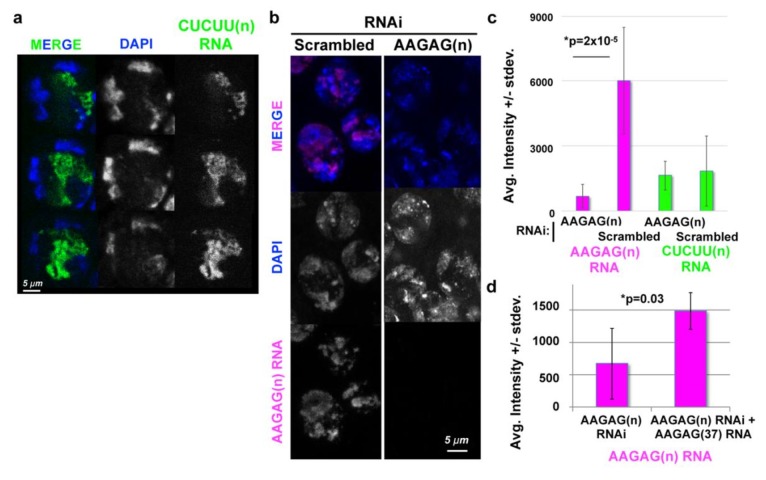
AAGAG RNA and not CUCUU RNA is substantially decreased in Bam-GAL4- driven AAGAG RNAi, and AAGAG RNA levels are increased in rescue experiments.(a) Although visibly absent in embryos and somatic larval tissues, CUCUU RNA (green) is expressed in adult spermatocytes. Note that CUCUU RNA is localized to the S5 lumen, internal to the chromatin (DAPI), in contrast to the peripheral localization of AAGAG RNA (see Figure 3b); DNA = DAPI (blue). (b) Projections of AAGAG foci (magenta) in S5 spermatocytes after Bam-GAL4-driven Scrambled control or AAGAG RNAi. Signal was imaged with the same laser intensities for each genotype. (c) Average median intensities (arbitrary units, ± st. dev.) of AAGAG RNA, p=2×10−5 and CUCUU RNA in S5 spermatocytes in AAGAG and Scrambled RNAi testes (not significant). This represents a 72% reduction of AAGAG RNA in S5 spermatocytes after AAGAG RNAi, compared to scrambled controls, with little to no decrease in CUCUU RNA. (d) Average intensity of AAGAG RNA in S5 spermatocytes after AAGAG RNAi increases significantly (p=0.03) upon co-expression of AAGAG(37) RNA (also induced by the Bam-Gal4 driver). two tailed, type three t test used for all.